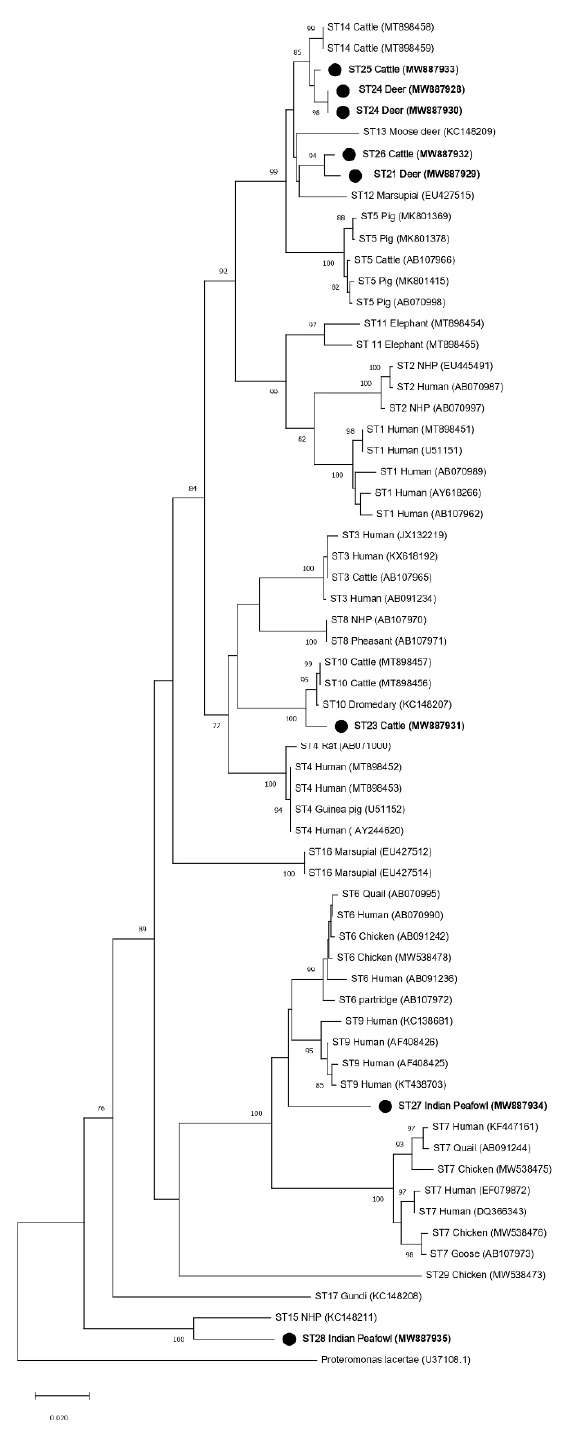
Figure 5. Phylogenetic relationships among Blastocystis partial SSU rRNA gene sequences of the barcoding region generated in the present study (represented with a black filled circle) and representative reference sequences of the accepted subtypes (Table 2). Proteromonas lacertae was used as outgroup taxon to root the tree. Analysis was conducted by a neighbor-joining method. Genetic distances were calculated using the Kimura two-parameter model. This analysis involved 64 nucleotide sequences, and there were a total of 587 positions in the final dataset. Bootstrap values lower than 75% are not displayed.